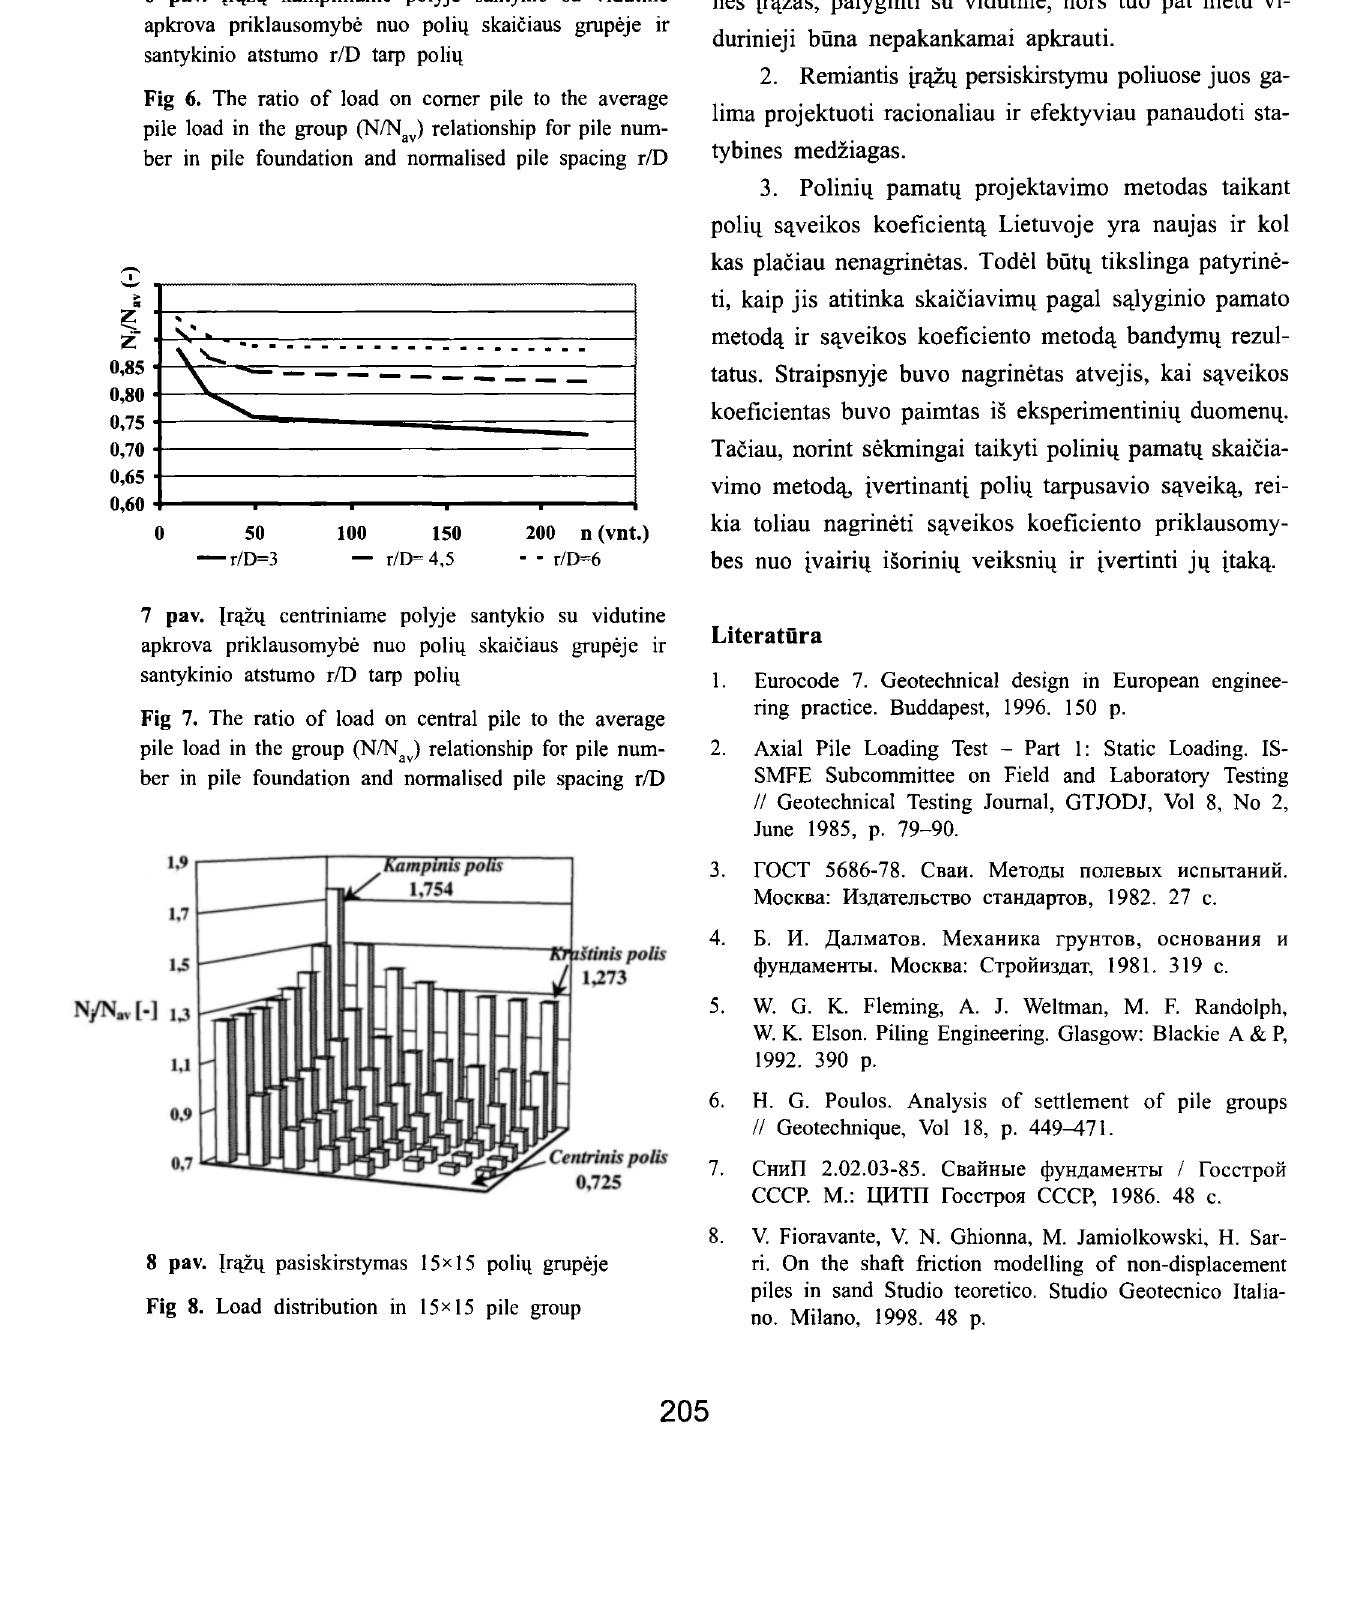
Fig 6. The ratio of load on corner pile to the average pile load in the group (NIN.) relationship for pile num ber in pile foundation and normalised pile spacing riD